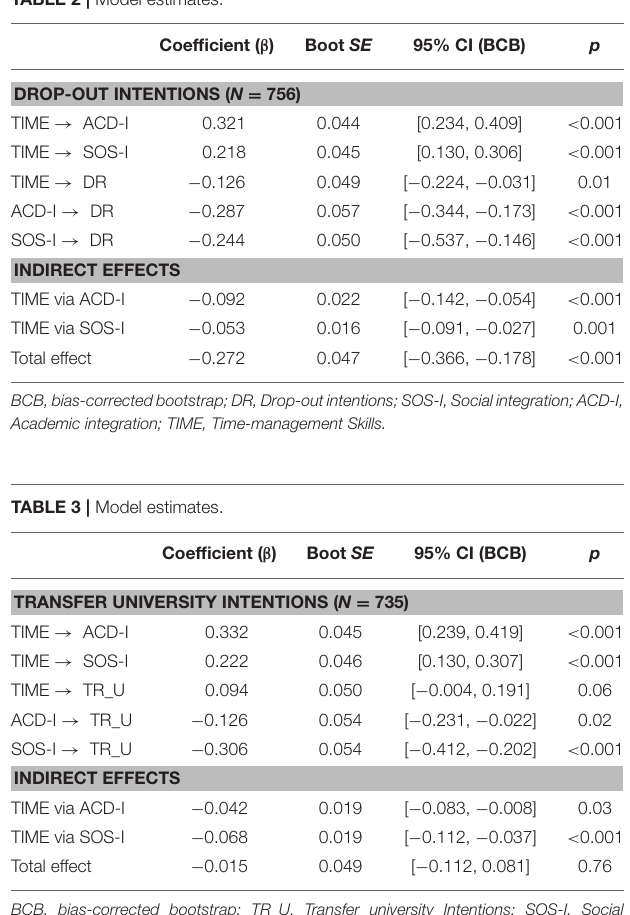
TABLE 2 | Model estimates.